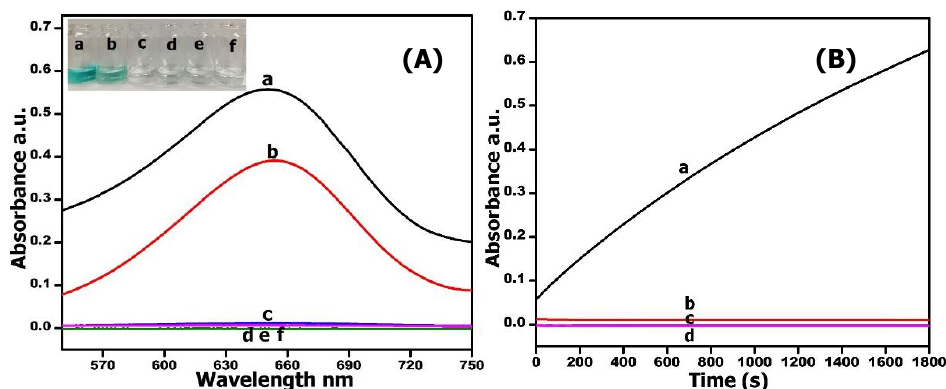
Figure 8. ( A ) displays the UV-Vis spectra of different reaction systems, and the inset shows the corresponding photograph. The UV-Visible absorption spectra of (a) catalytic reaction volume containing DI water (neutral pH) + TMB (2.5 mM) + H 2 O 2 (2.5 µM) + GO dispersion (5 µg mL −1 ) + ZrCl 4 (0.5 mg mL −1 ). The mixture was blended and incubated at room temperature for 5 min. (b) TMB+H 2 O 2 +Zr, (c) TMB+H 2 O 2 +GO (d) TMB+Zr (d) TMB+H 2 O 2 (e) TMB+H 2 O 2 (f) H 2 O 2 +Zr. ( B ) The time-dependent absorbance responses of different systems.